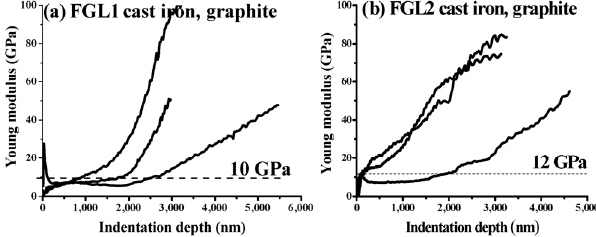
Fig. 4 Young’s modulus of graphite phase in FGL1 and FGL2 cast